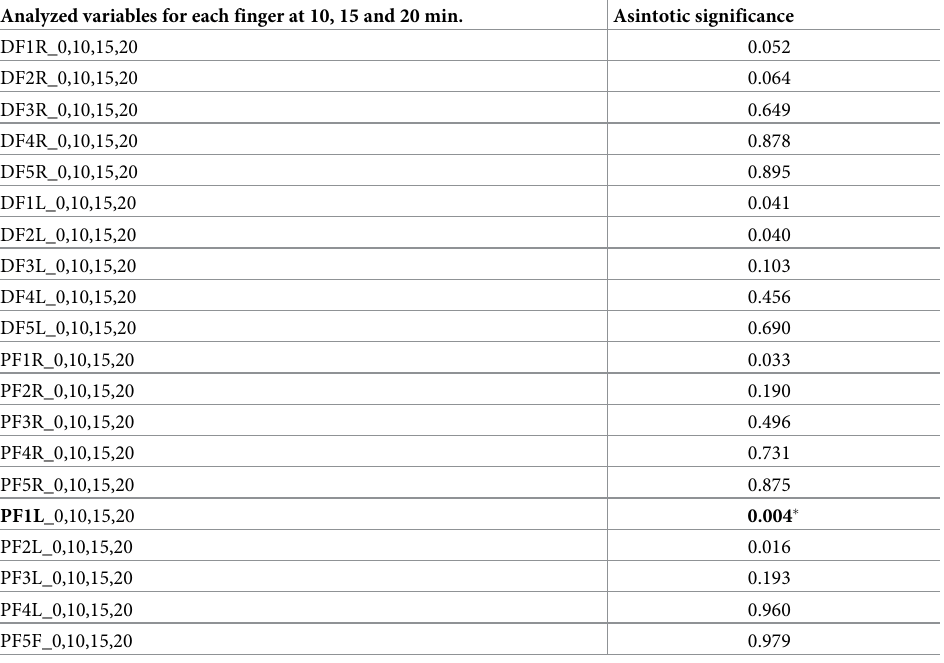
Table 3. Friedman test between times of ROIs. Analyzed variables for each finger at 10, 15 and 20 min.